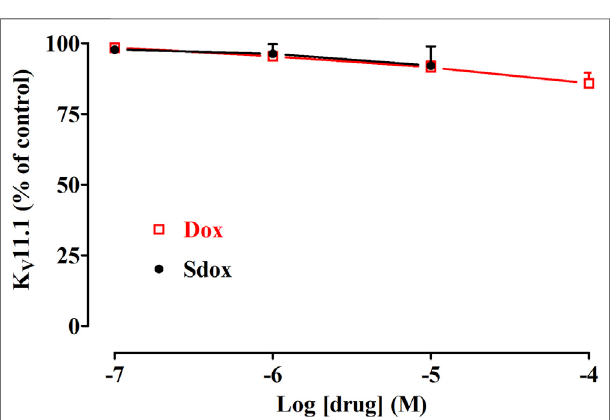
FIGURE 6 | Effect of Dox and Sdox on K V 11.1 (hERG) current recorded in hERG-HEK293 cells. Concentration-dependent effect of Dox and Sdox of hERG tail currents. On the ordinate scale, current amplitude is reported as a percentage of the value recorded just before the addition of the fi rst concentration of the drug. Data points are the mean ± SD ( n =